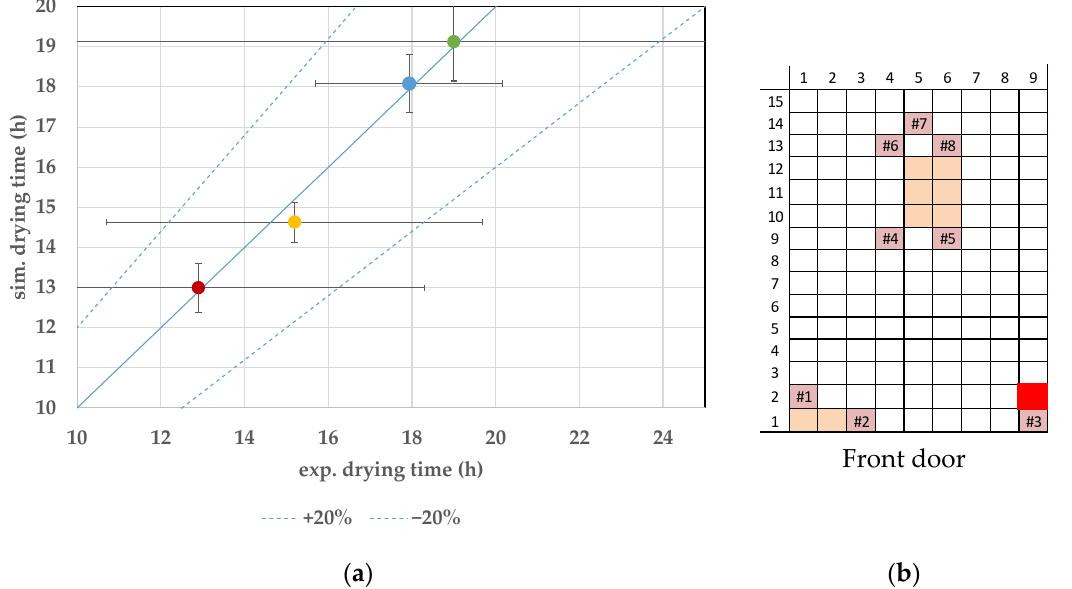
Figure 10. ( a ) Parity plot between the simulated and experimental primary drying endpoints for vial 2.9 (red: + − , yellow: ++, blue: CP, green: −− ). ( b ) Vial position.